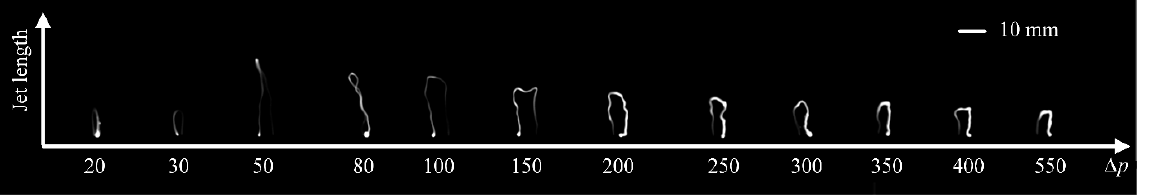
Figure 12. Maximum jet length of gliding arc captured by the high-speed camera at different ∆ p values .